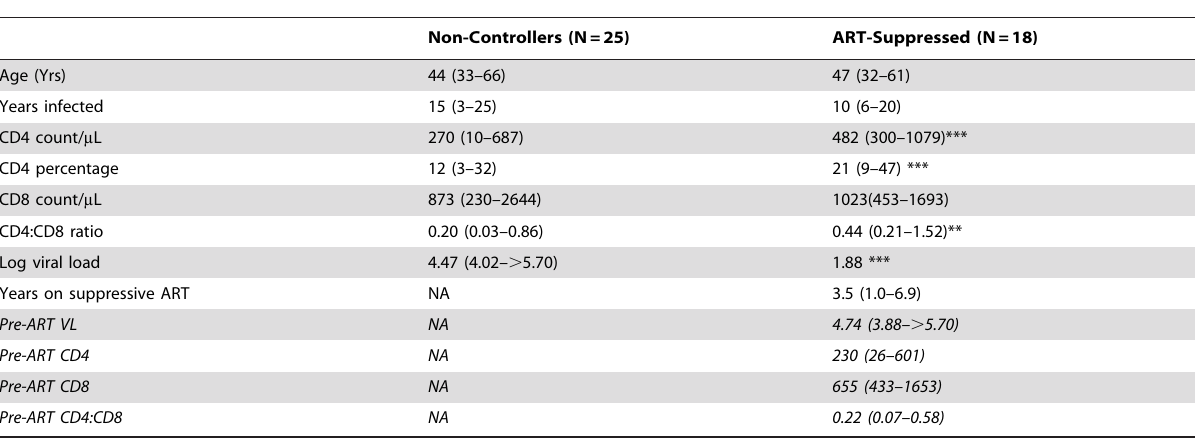
Table 2. Baseline Characteristics of Subjects Studied by Flow Cytometry.